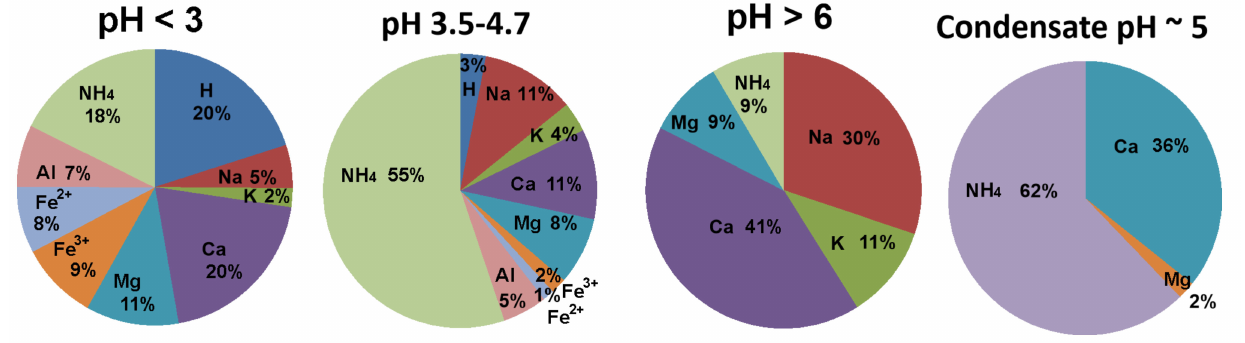
Figure 7. Fractional ratios of basic cations in thermal waters and gas-condensate from Dachnoe thermal